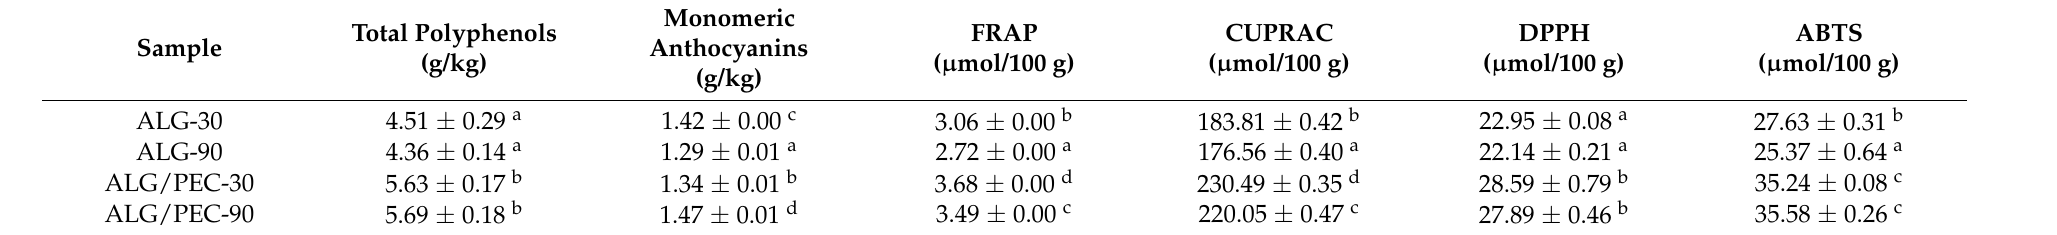
Table 2. Total polyphenols, anthocyanins and antioxidant activity of hydrogel beads.